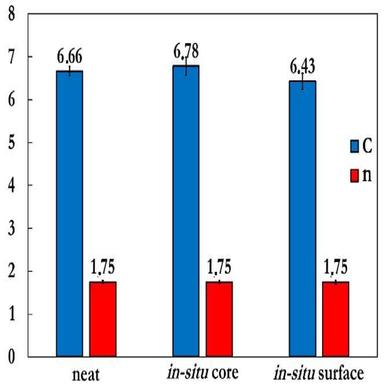
C and n fitting coefficients of the (first) loading curves for neat resin and composite core and surface.